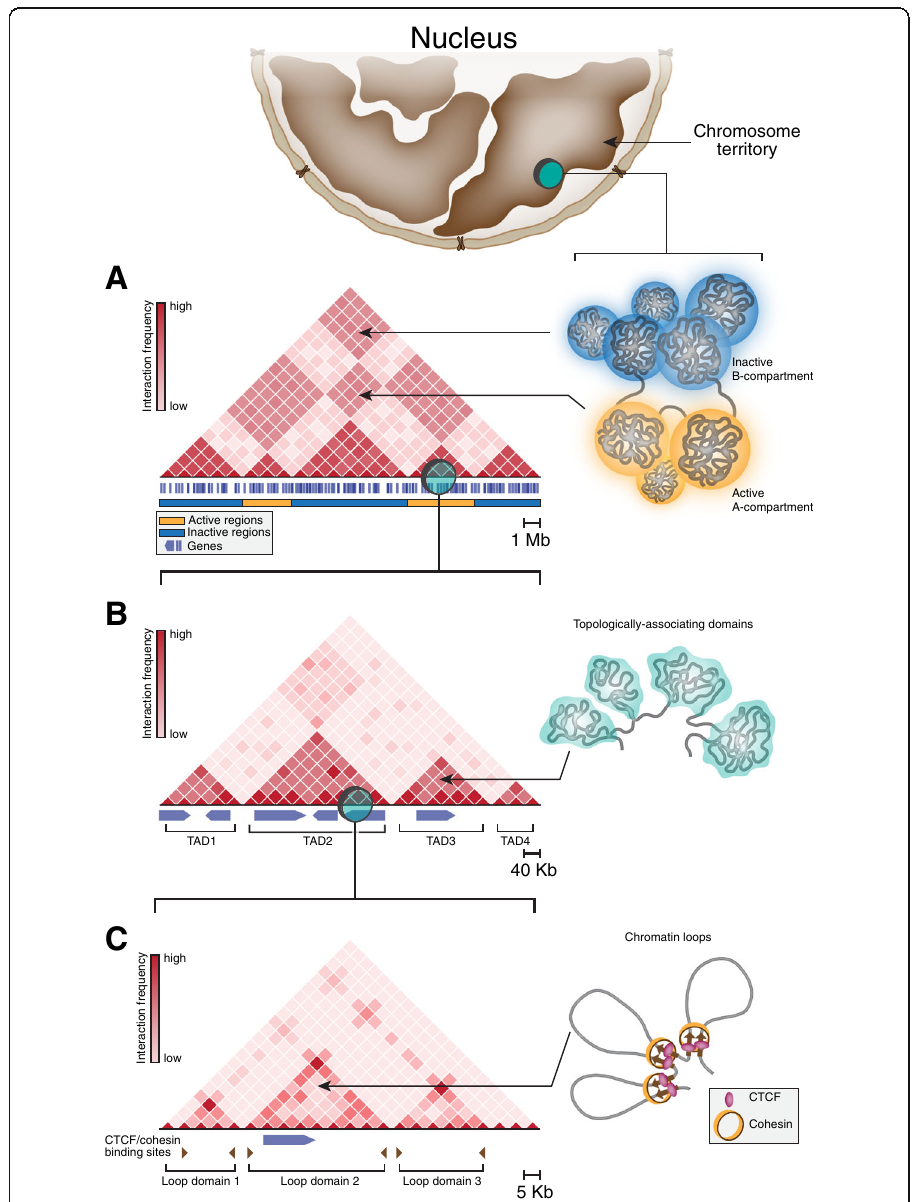
Fig. 1 A scheme illustrating the hierarchical structure of interphase chromatin. Chromosome territories (at the top of the picture) are partitioned into A- and B-compartments ( a ) formed by long-range spatial interactions between distant genome loci and containing active and repressed genome regions, respectively. At a sub-megabase level, chromatin is folded into topologically-associating domains, TADs ( b ), commonly interpreted as self-interacting globular structures those positions are largely conserved across cell types. The internal structure of TADs is represented by arrays of so-called loop domains formed by spatial contacts between CTCF/cohesin-binding sites ( c ). Color intensity on illustrative Hi-C maps (on the left side of each panel) reflects average interaction frequency between corresponding genomic